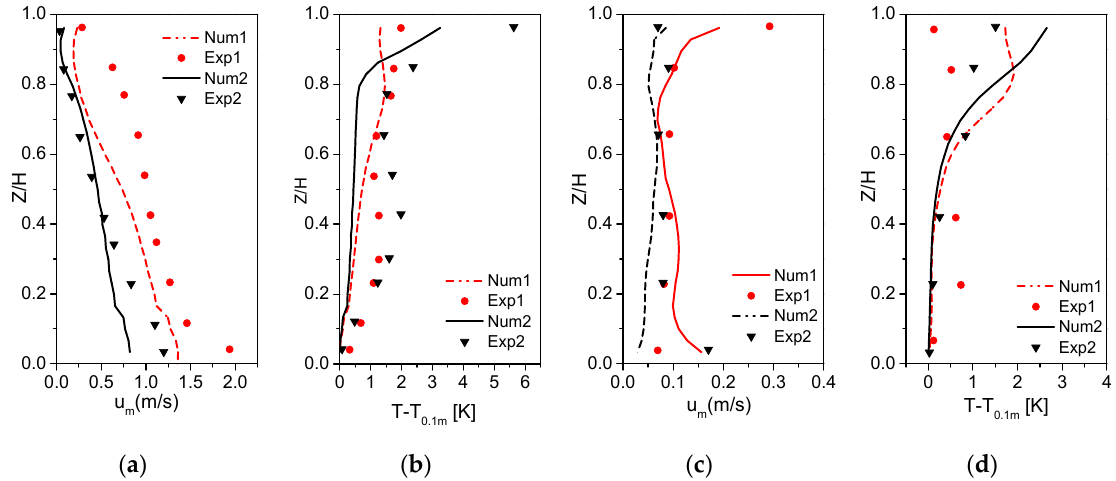
Figure 3. The comparison of simulated air velocity and temperature against the experimental data: ( a , b ) Jet centerline; ( c , d ) Free area (T 0.1 m is air temperature at 0.1 m height)